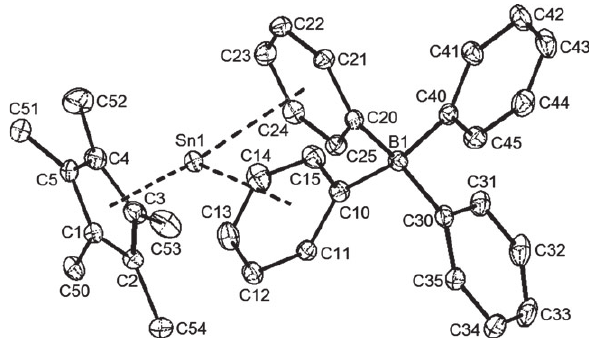
Figure 1 Molecular structure (Cp*Sn)BPh ellipsoids and the crystallographic numbering scheme. Selected bond parameters are as follows ( Å ): Sn1-C1 2.510 (2), Sn1-C2